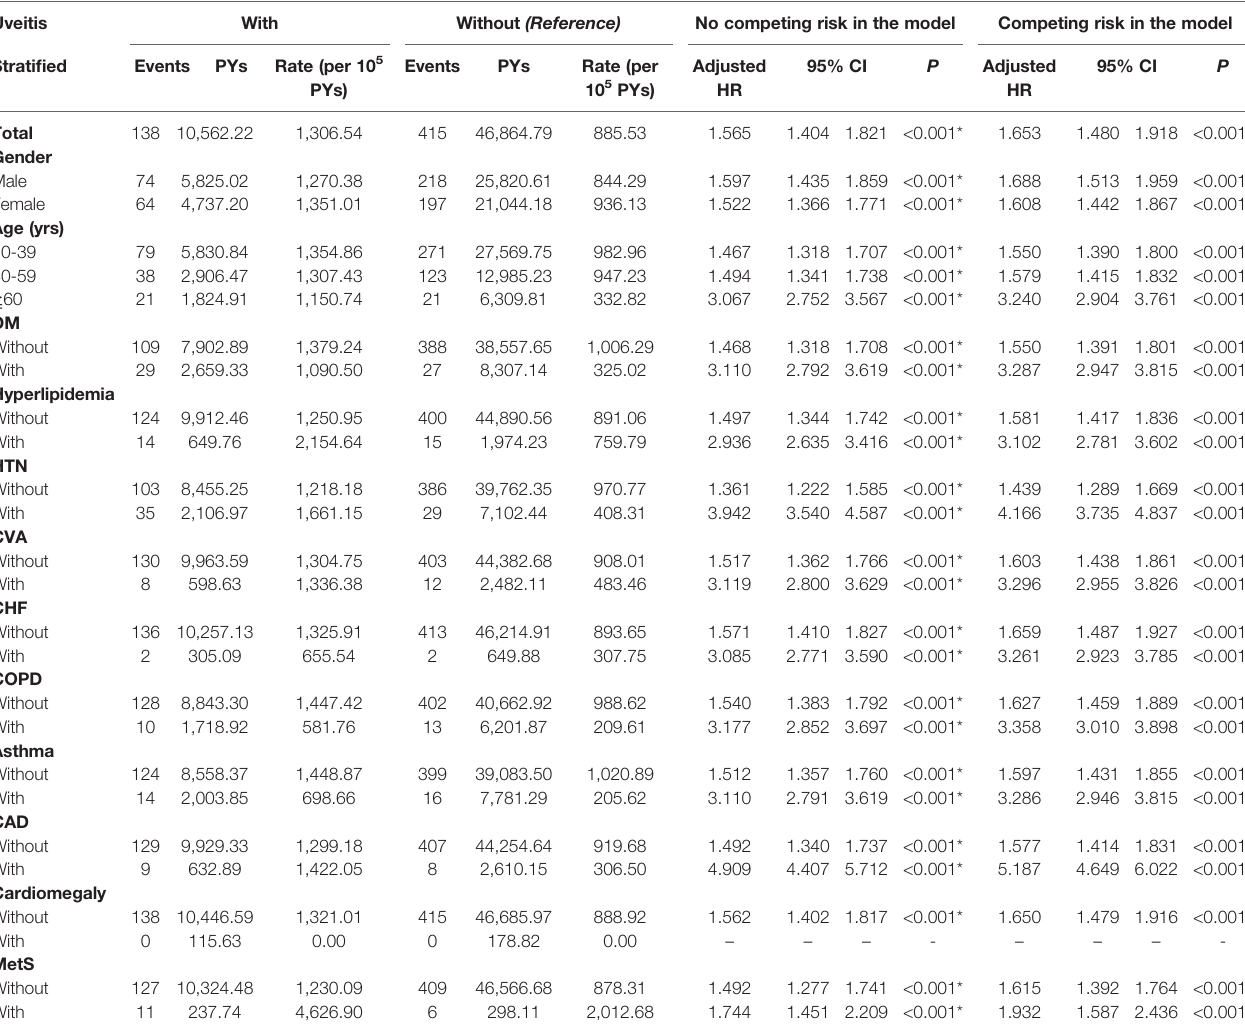
TABLE 3 | Factors for AMI strati fi ed by variables listed in the table evaluated by Cox regression with/without Fine & Gray ’ s competing risk model. Uveitis With Without (Reference) No competing risk in the model Competing risk in the model